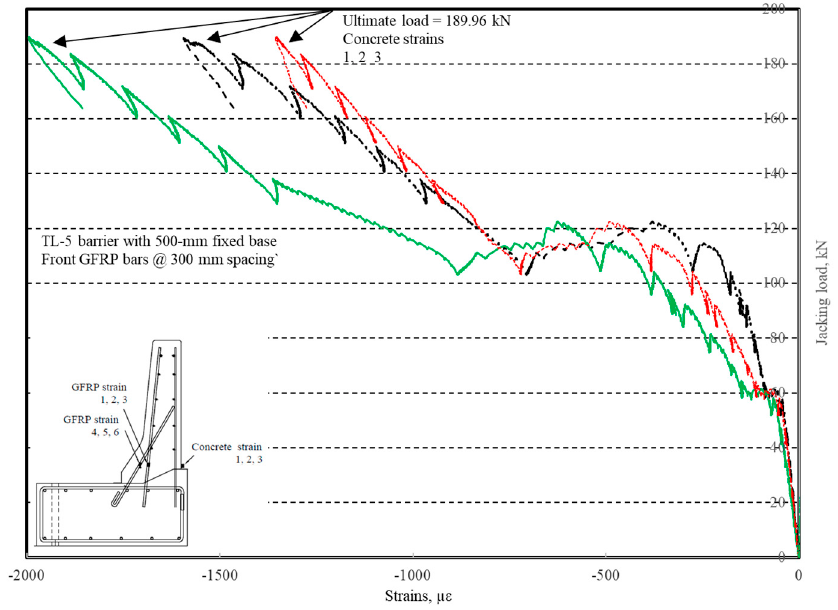
Figure 25. Specimen # 4: Load vs. concrete strain history.